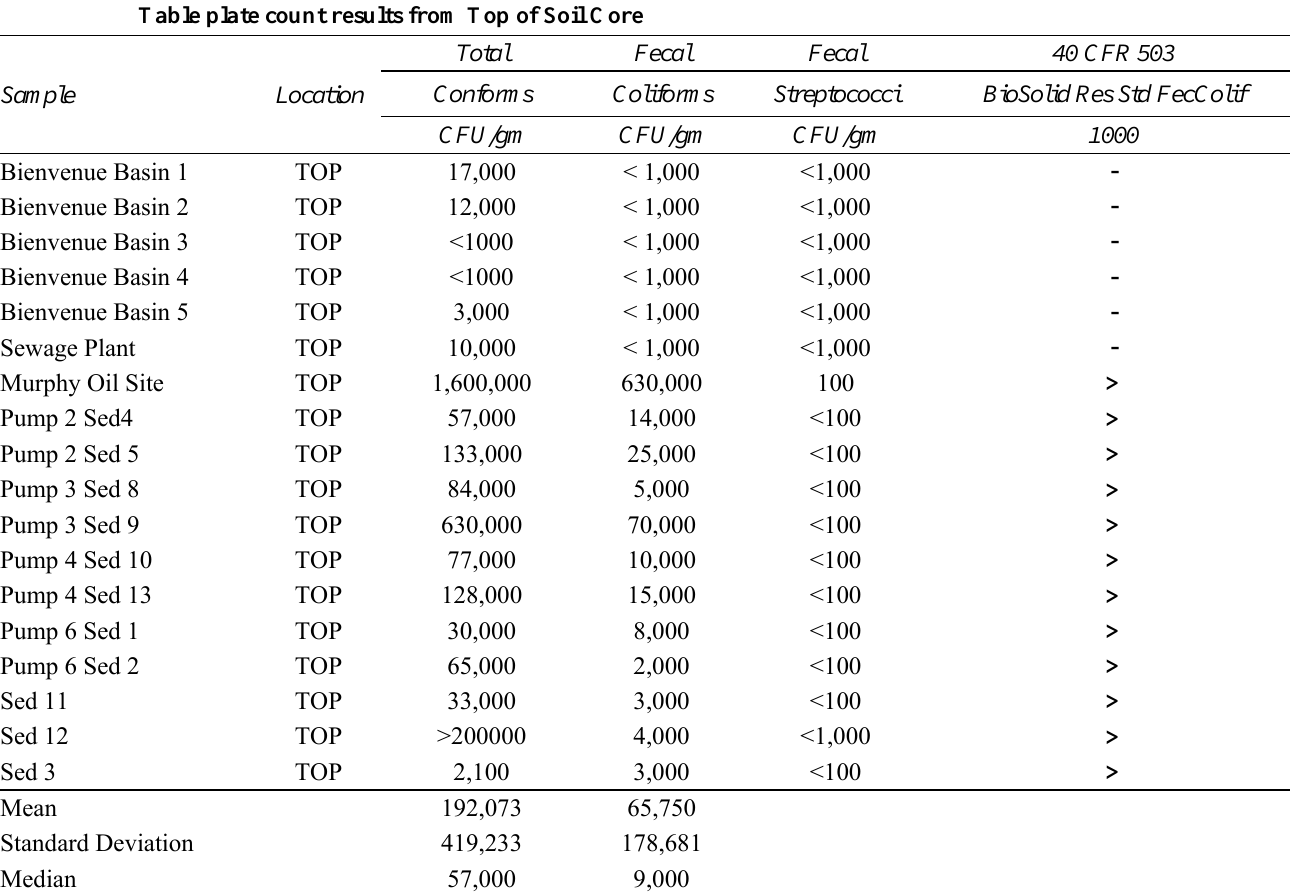
Table 2: Levels of fecal indicator bacteria in the surface sediments of cores collected in and around Violet Marsh. Table plate count results from Top of Soil Core